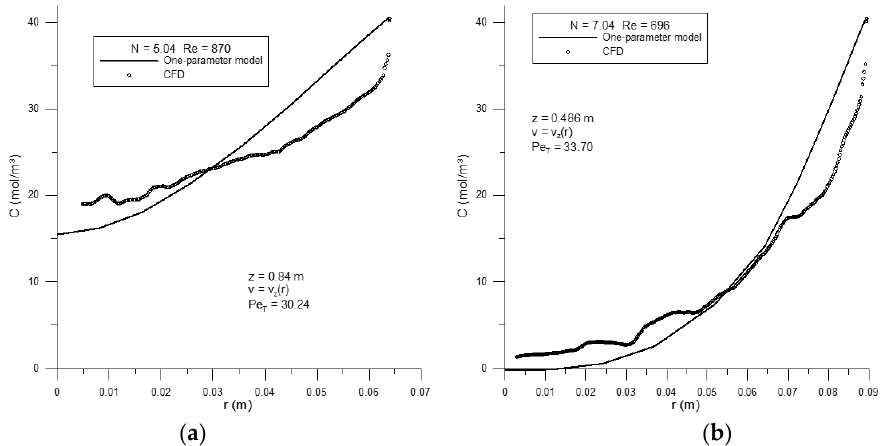
Figure 7. Representative comparisons of fits of the 1-parameter model using constant D T to simulated data from Validation of Computational Fluid Dynamics (CFD), for ( a ) N = 5.04 and Re = 870 and for ( b ) N = 7.04 and Re = 696.